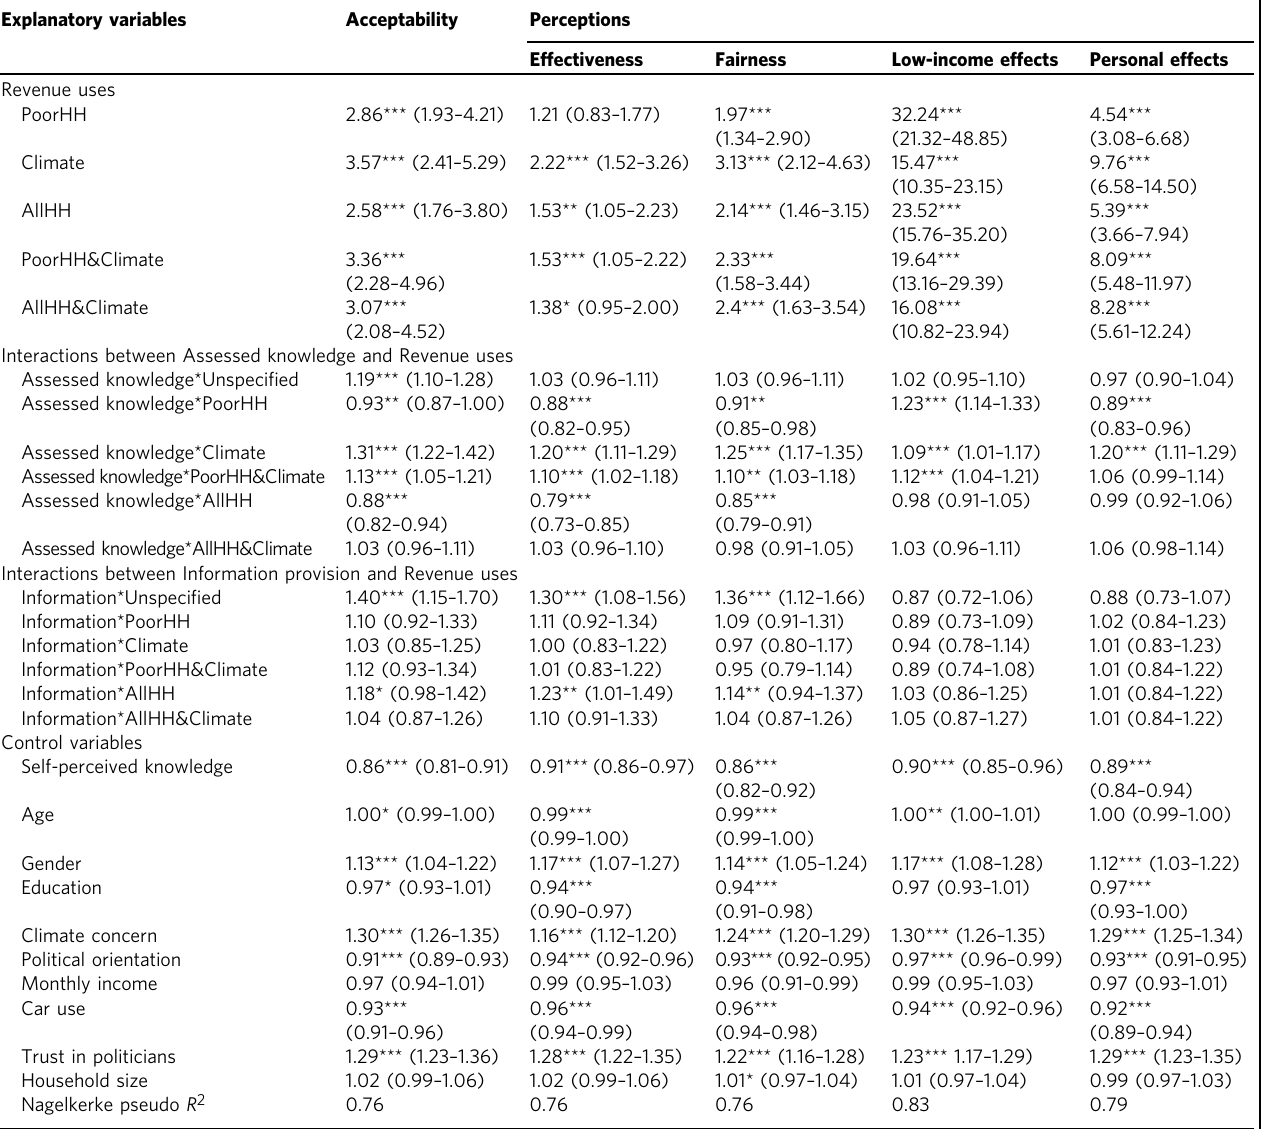
Table 1 Determinants of acceptability and